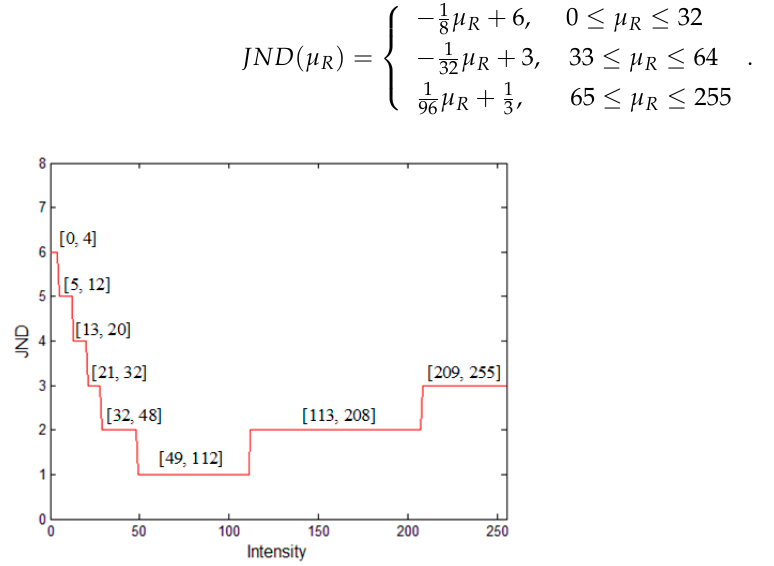
Figure 3. JND response.